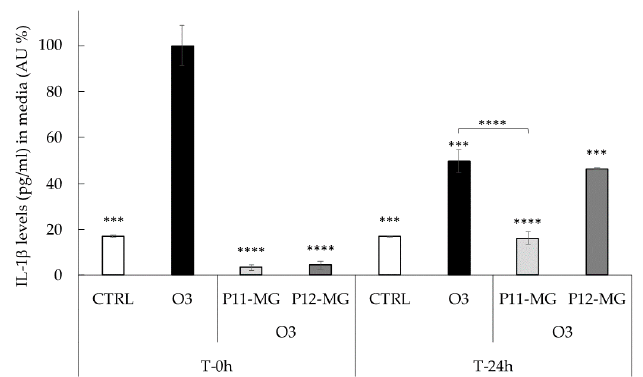
Figure 7. Levels of IL-1 β (pg/mL) in the media of 3D skin models treated with P11-MG and P12- MG analyzed using an IL-1 β ELISA kit 0 or 24 h after exposure to O 3 0.4 ppm for 4 h. Data were normalized with respect to the O 3 sample at 0 h and expressed as arbitrary units (%) ± SD. Data are the results of the averages of at least three different experiments. *** p ≤ 0.001, **** p ≤ 0.0001 vs. O 3 at T 0 h.